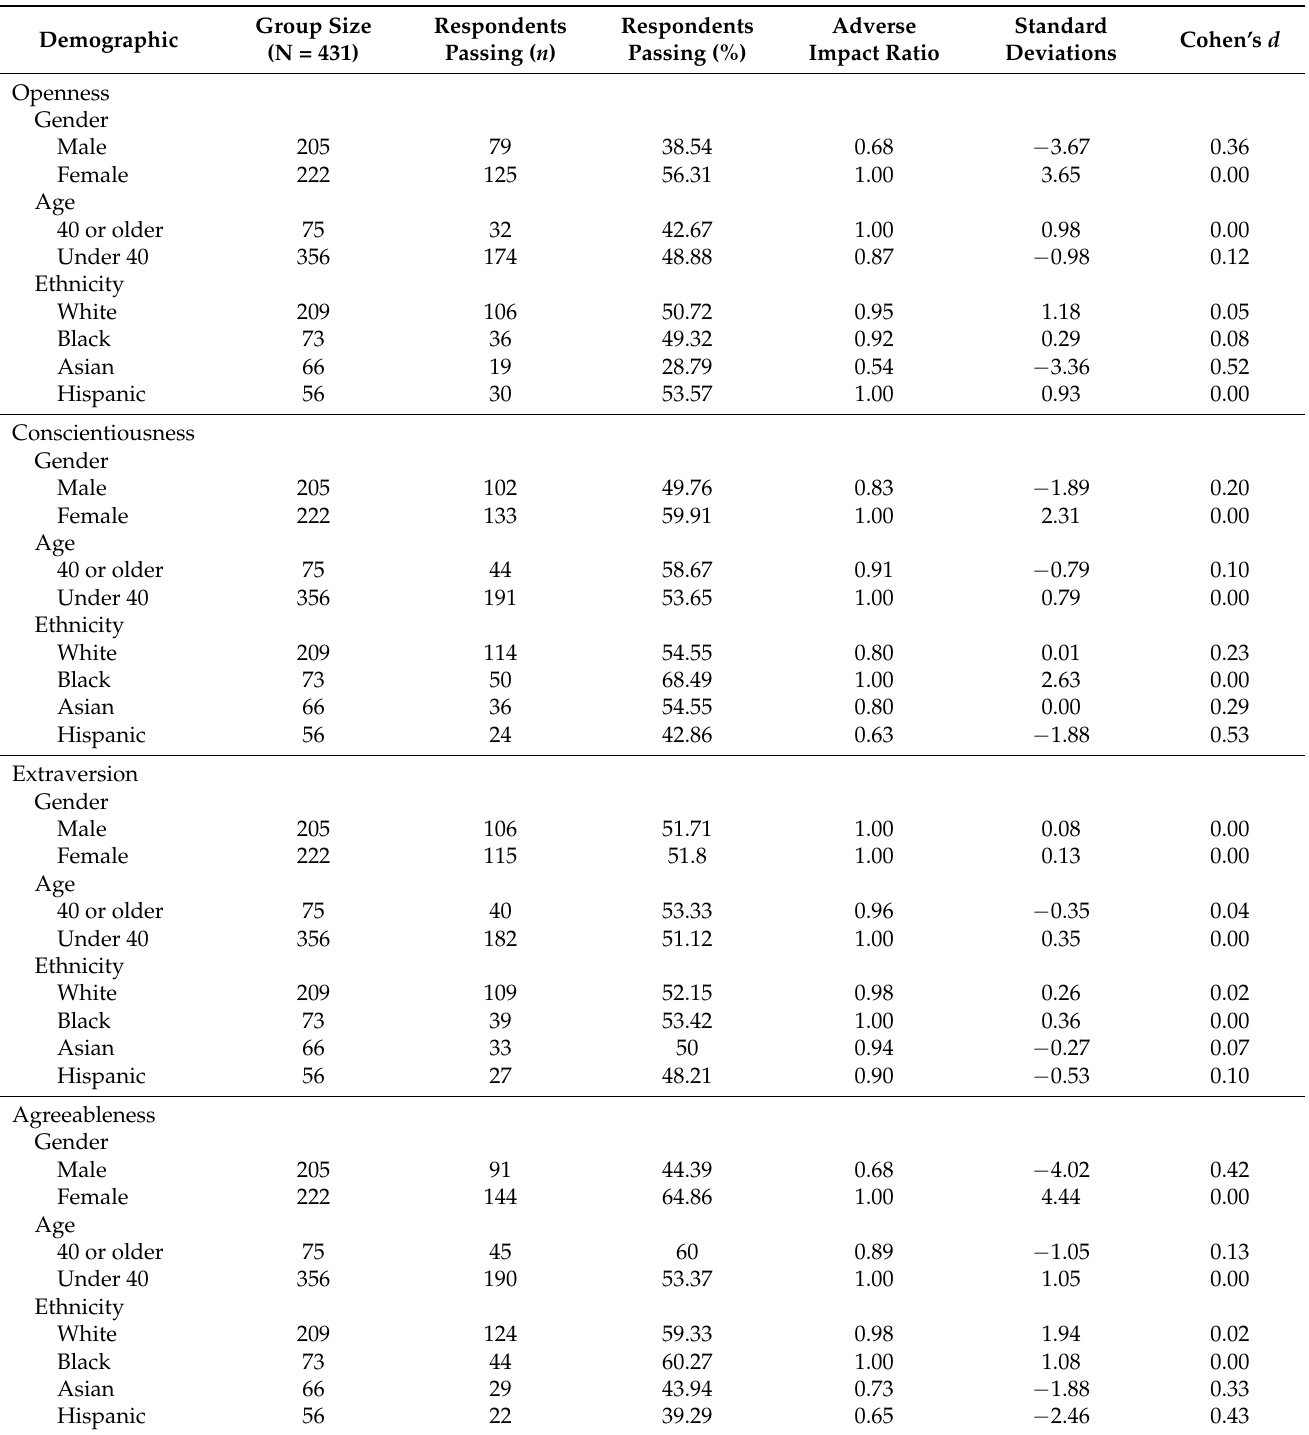
Table 5. The adverse impact analysis for the image-based assessment based on the four-fifths rule, two standard deviations rule, and Cohen’s d